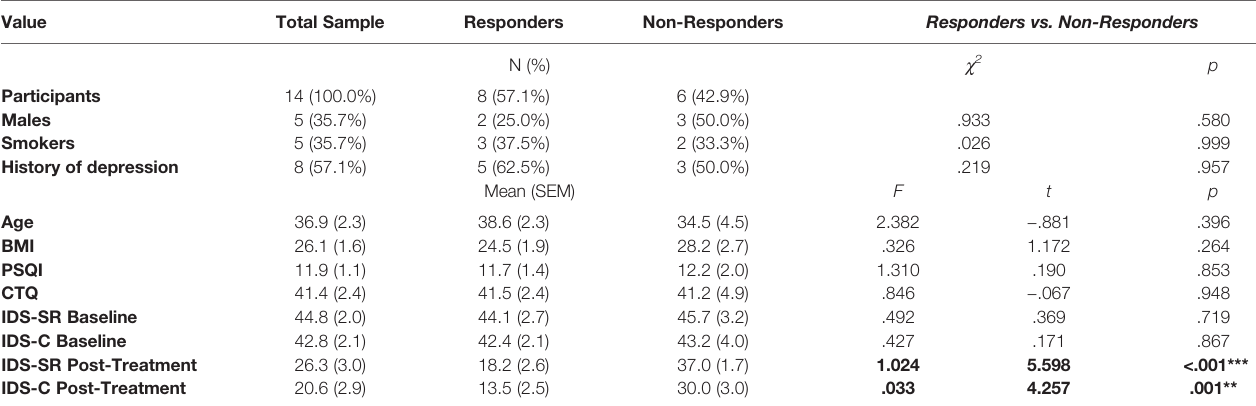
TABLE 1 | Demographic, physical, and psychometric measures in MDD patients and group differences between responders and non-responders to ESC antidepressant treatment. Value Total Sample Responders Non-Responders Responders vs. Non-Responders